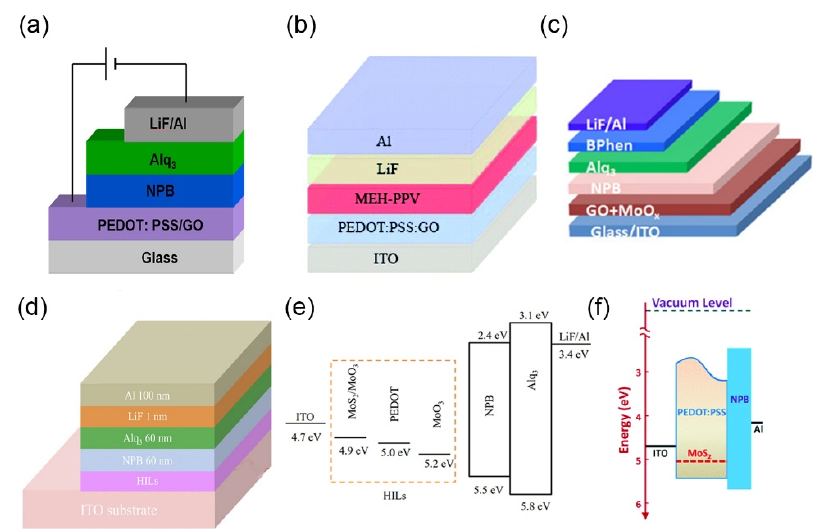
Figure 4. ( a ) Schematic structure of OLEDs with a poly(styrenesulfonate)-doped poly(3,4-ethylenedioxythiophene) (PEDOT:PSS)/Graphene Oxide (GO) composite anode, reprinted with permission from [53], Elsevier, 2015; ( b ) Schematic structure of PLEDs with a PEDOT:PSS:GO composite HTL, reprinted with permission from [52], Royal Society of Chemistry, 2014; ( c ) Schematic structure of OLEDs with a GO:MoO x composite HTL, reprinted with permission from [40], Wiley, 2018; ( d ) Schematic structure and ( e ) energy level diagram of OLEDs with different HILs, reprinted with permission from [56], AIP Publishing LLC, 2018; ( f ) Energy level diagram of ITO/MoS 2 :PEDOT:PSS/NPB interface, reprinted with permission from [41], Royal Society of Chemistry, 2019.